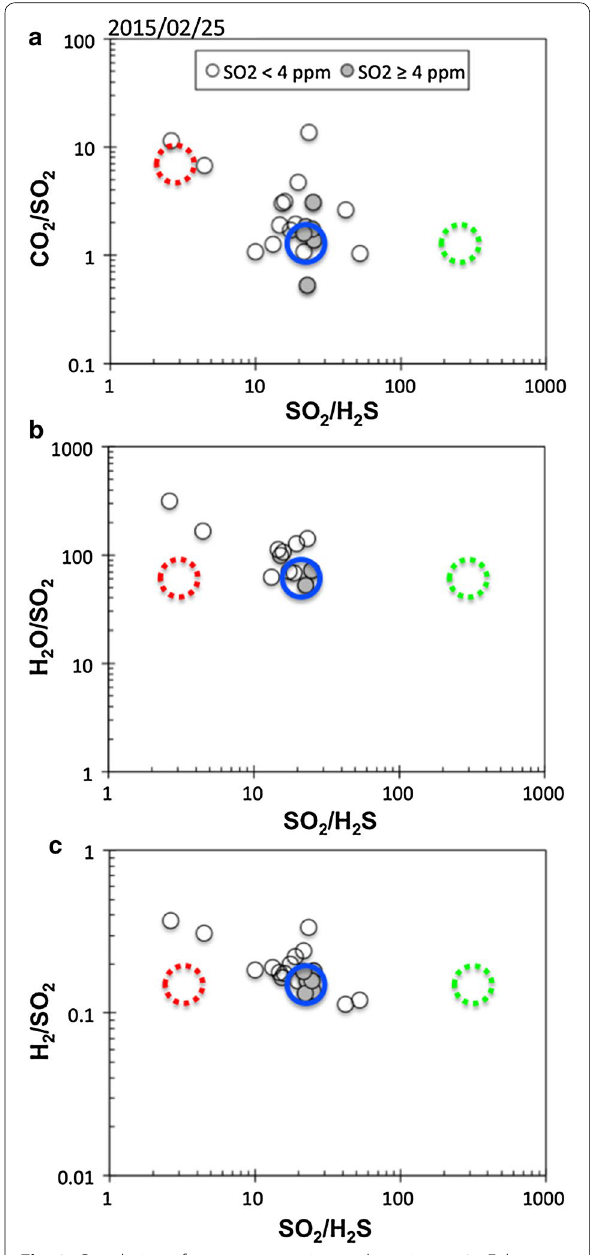
Fig. 9 Correlation of gas concentration molar ratios on 25 February 2015. a correlation of CO 2 /SO 2 molar ratio with SO 2 /H 2 S molar ratio, b correlation of H 2 O/SO 2 molar ratio with SO 2 /H 2 S molar ratio, and c correlation of H 2 /SO 2 molar ratio with SO 2 /H 2 S molar ratio. Grey circles show ratios obtained for high concentration peaks of SO 2 ppm, and white circles are ratios of low concentration peaks of SO 2 > 4 ppm. Blue circle indicates the composition B’, and red and green dotted circles indicate the compositions A and B,